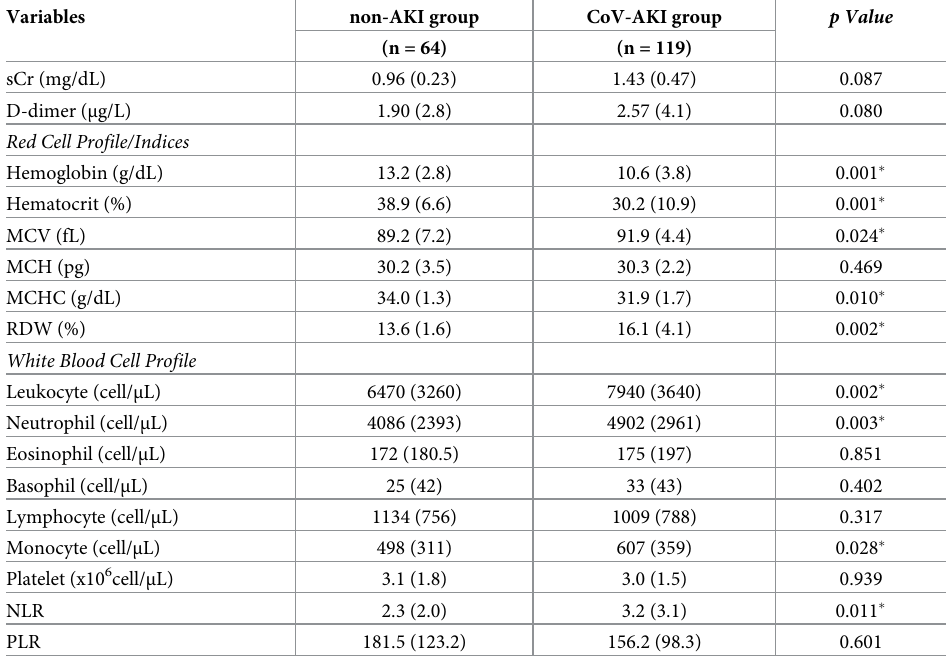
Table 4. Description of biochemical data and blood cellular profile at hospital